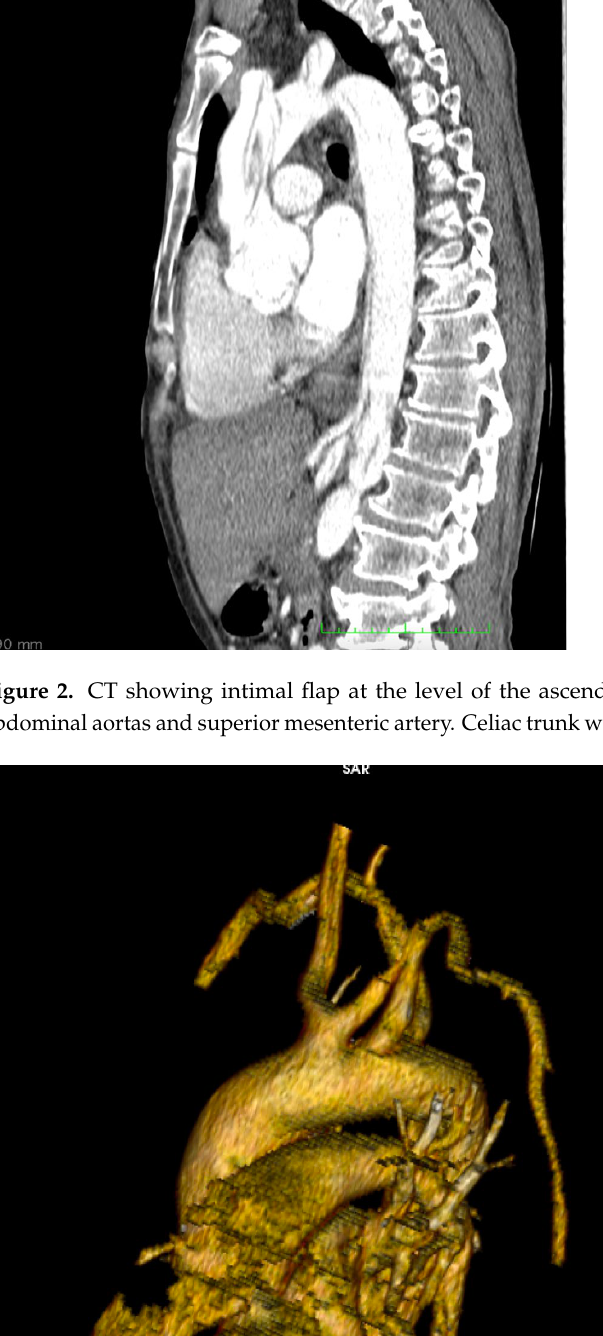
Figure 4. Intimal flap present in all the supra-aortic vessels.